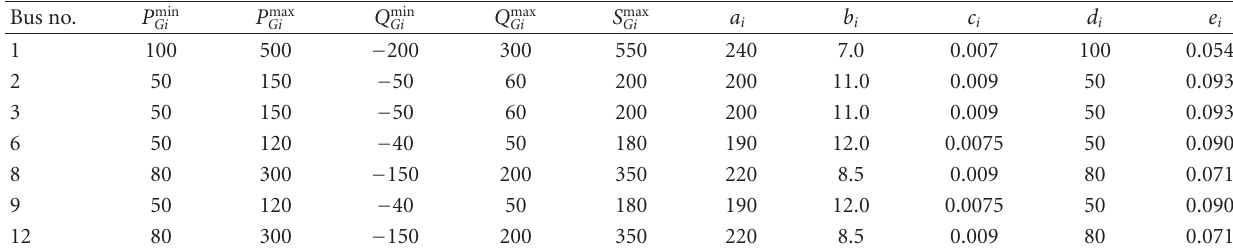
Table 2: Generating unit capacity and coe ffi cients in IEEE 57-bus System.